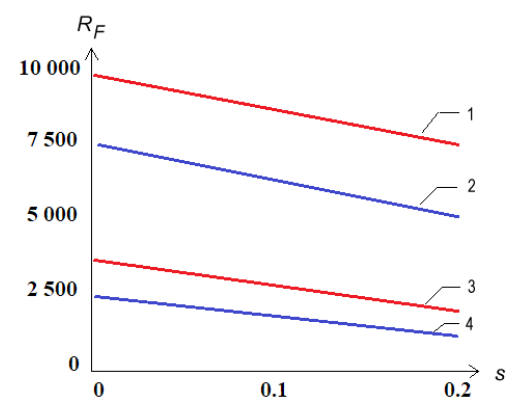
Fig. 1 . Effects of protection G0> with adaptive